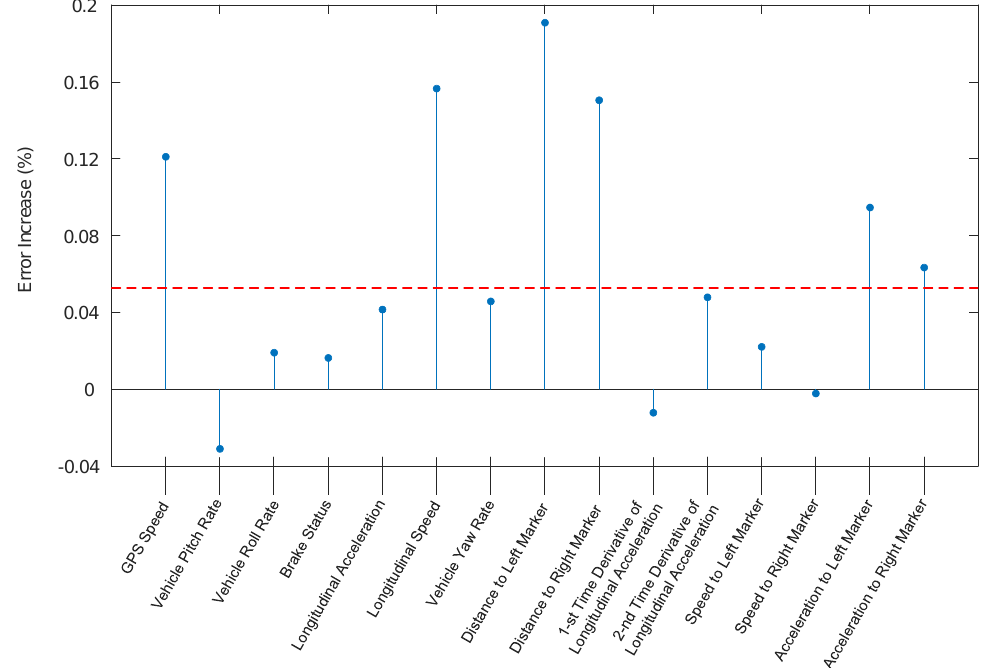
Figure 2. Mean of the importance of the original features.